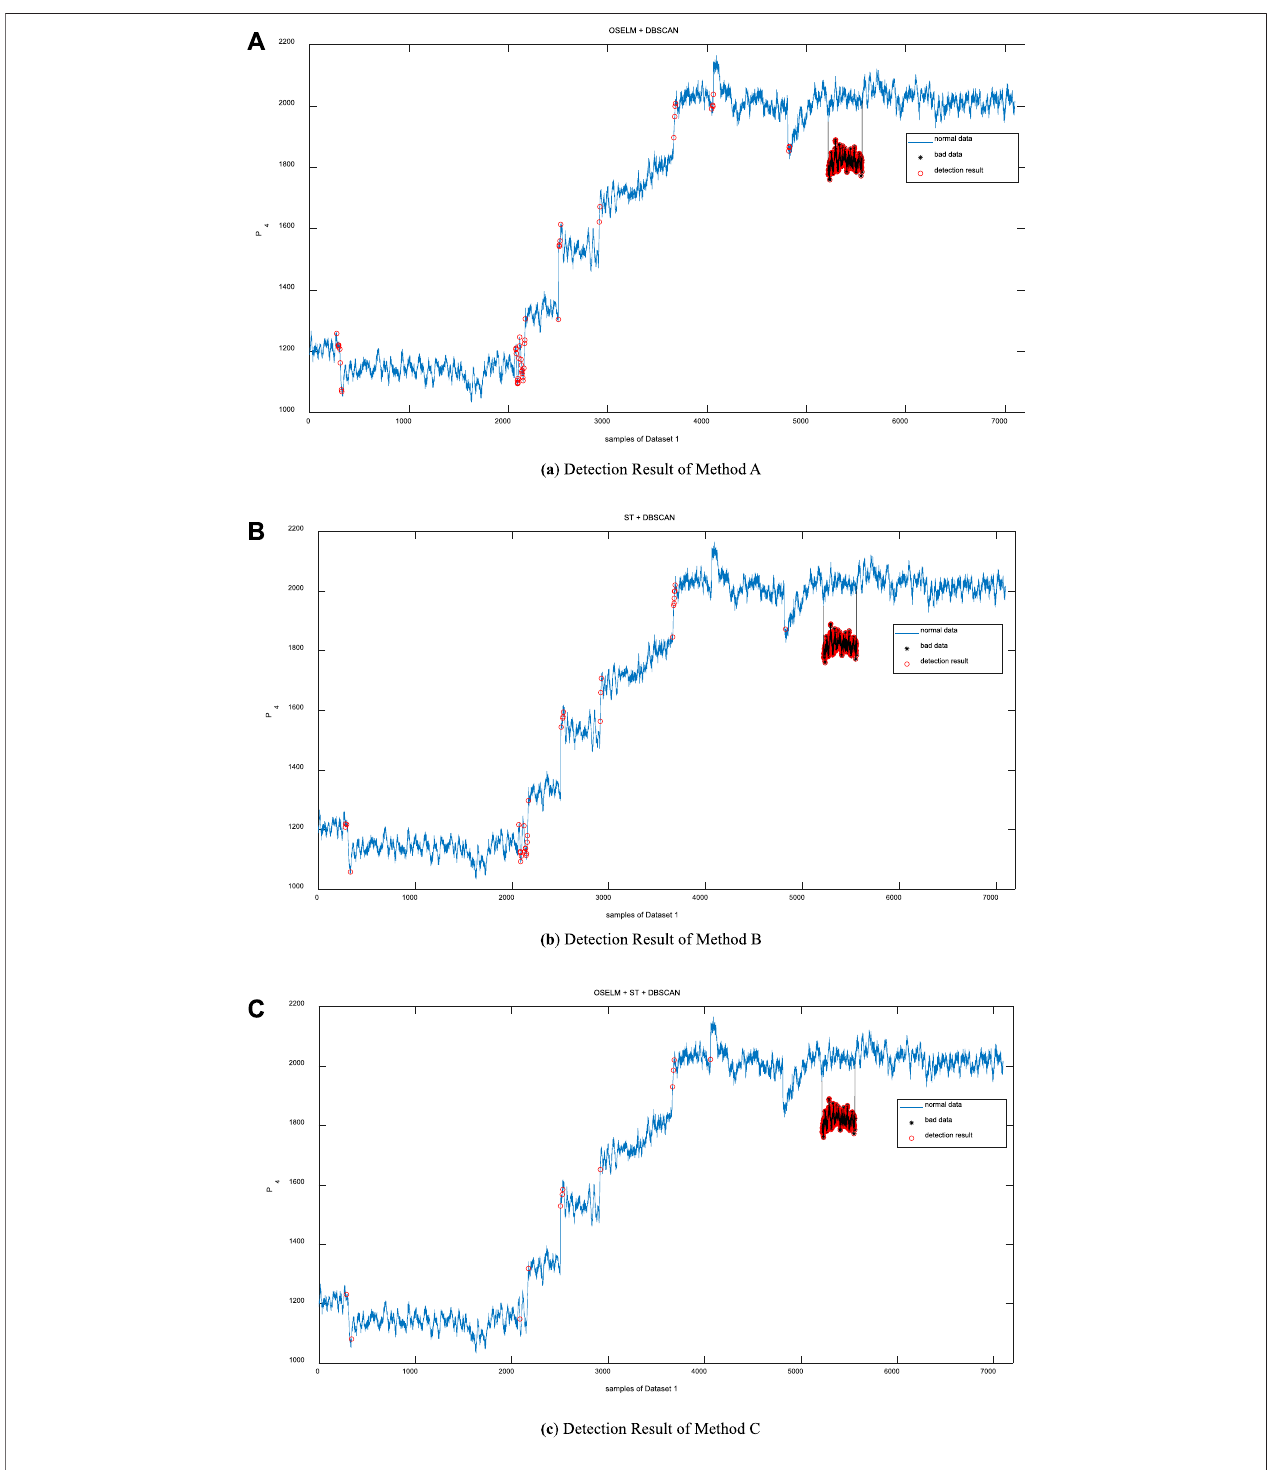
FIGURE 11 | Amplitude deviations